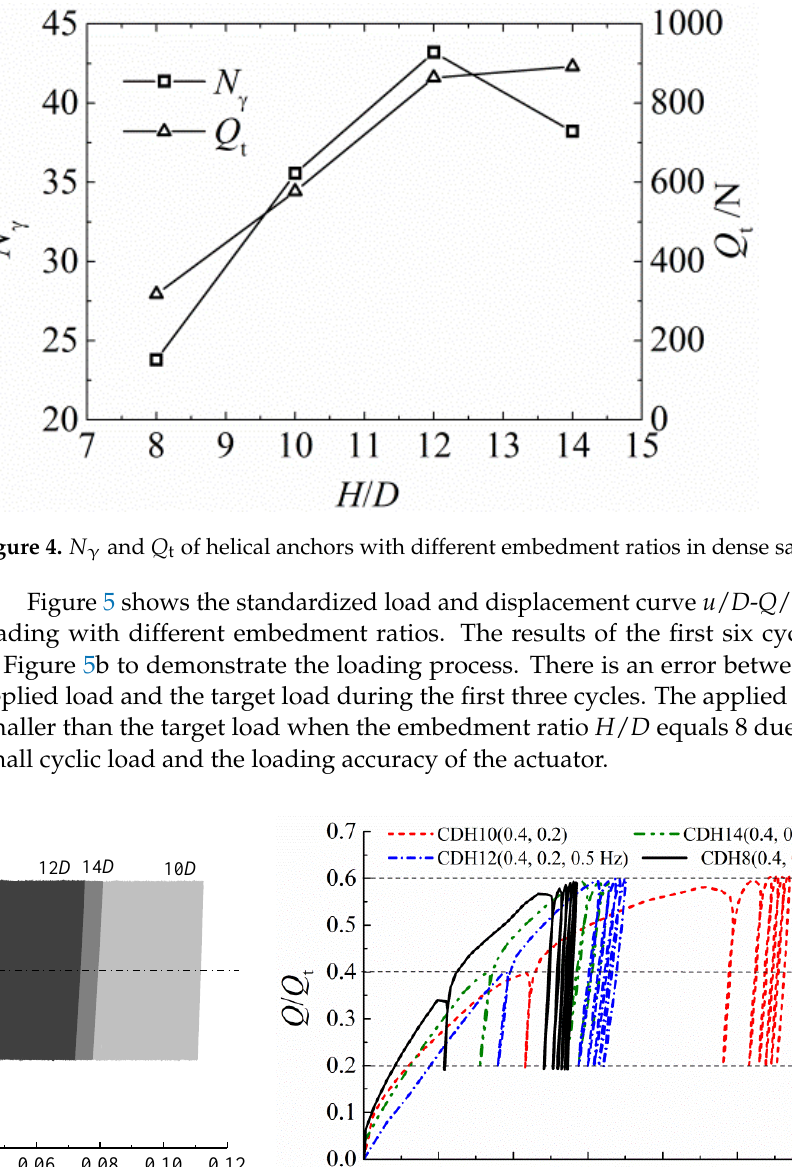
Figure 6. Developments of uplift displacement at different embedment ratios. •